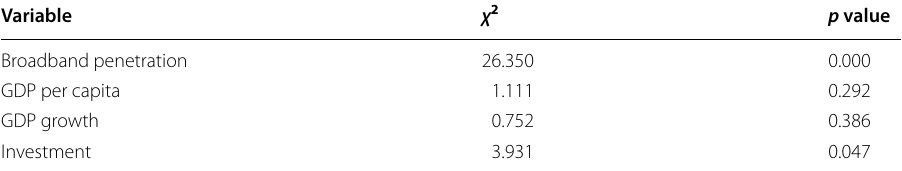
Table 2 Endogeneity test by Hausman proposed method Variable χ 2 p